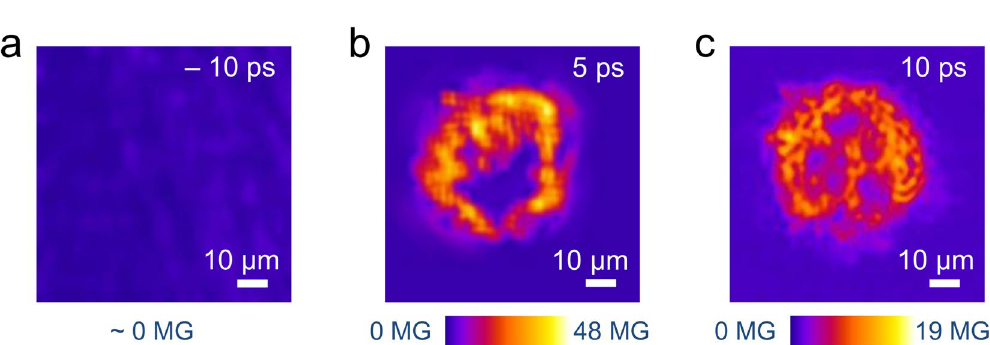
Figure 2. The magnetic field profile at the rear of a 1 mm × 1 mm, 50- μ m thick plastic (CH) target at a temporal delay of ( a ) - 10 ps, ( b ) 5 ps and ( c ) 10 ps after the main interaction pulse (negative delay indicates that the probe reached the target before the main interaction pulse). The spatial resolution of the optical